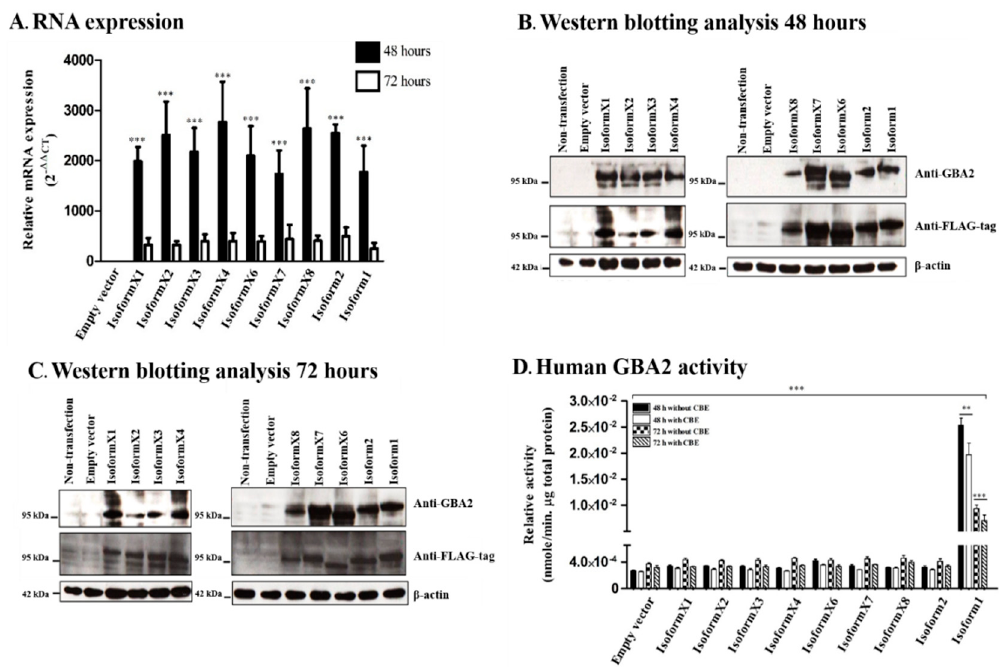
Figure 3. Expression of human GBA2 RNA, protein and activity in COS-7 cells transfected with human GBA2 isoforms. ( A ) RNA expression levels of hGBA2 compared between 48 and 72 h conditions as well as to empty vector control at 48 h; ( B , C ) Western blot analysis with di ff erent incubation times, 48 and 72 h, using anti-GBA2 and anti-FLAG-tag antibody; ( D ) activity determination of hGBA2 compared between 48 and 72 h as well as between with and without inclusion of CBE. All experiments were done with three independent biological replicates, and means and standard deviations are shown in A and D with * indicating di ff erences with p < 0.05, ** indicating p < 0.01, *** indicating p < 0.001 in a two-tailed unpaired t-test and ANOVA with Tukey’s multiple comparison for di ff erent time points. Shapiro–Wilk analysis showed no significant deviance from a normal distribution. For Western blots ( B , C ), the most clear example from the three similar replicates of independent biological samples is shown.